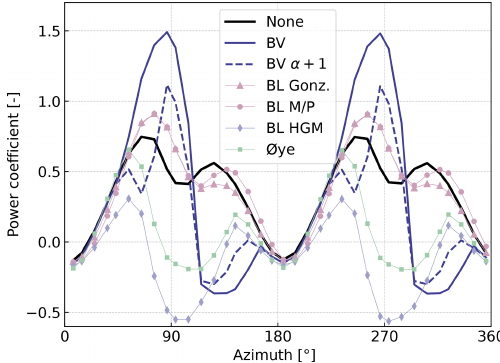
Figure 8. Influence of the choice of dynamic stall model on the power coefficient of a 2D